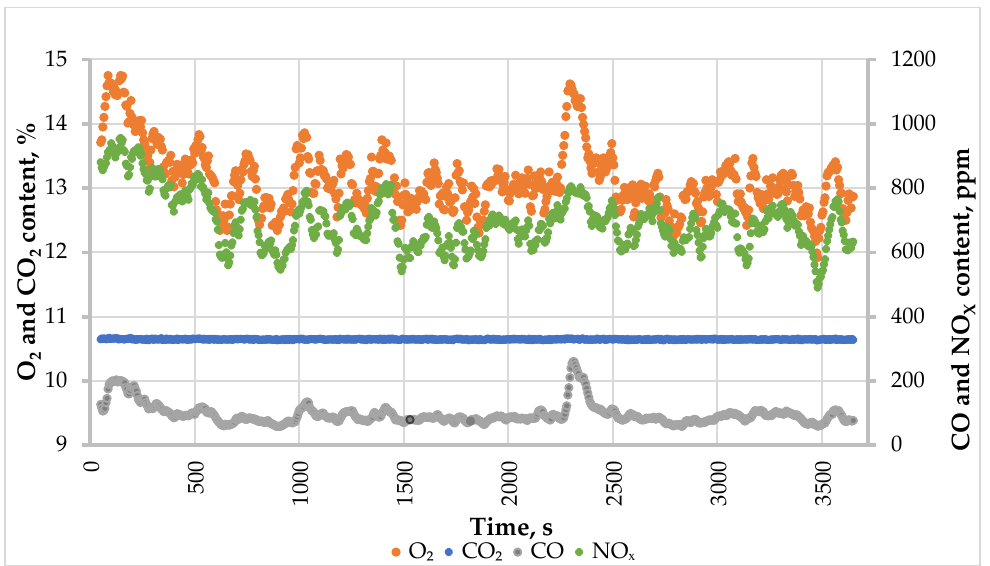
Figure 6. Chemical composition of flue gases during the combustion of wood-based waste pellets with additive Ad1.